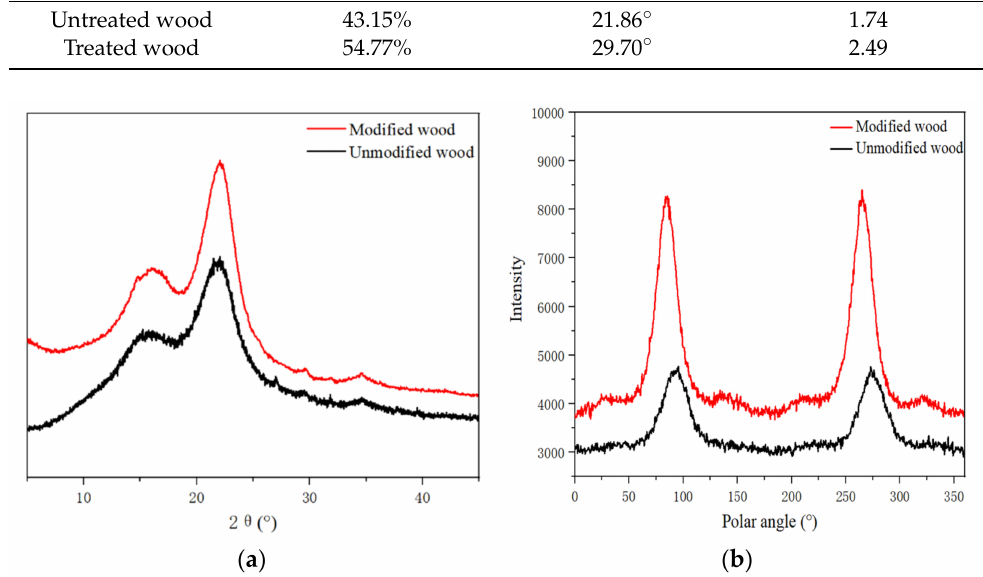
Figure 3. XRD patterns ( a ) and MFA ( b ) of modified and unmodified